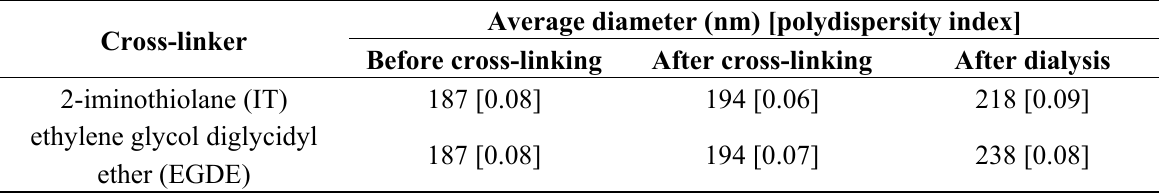
Table 1. DLS data for PAMAM dendron-PLL polymer vesicles and nanocapsules.